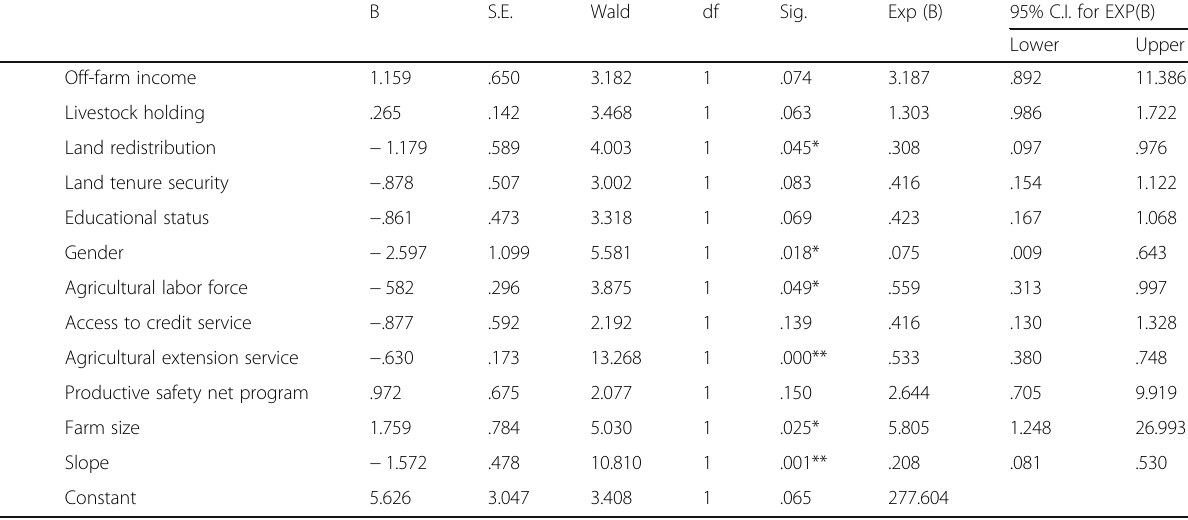
Table 3 The statistical results of the regression analysis